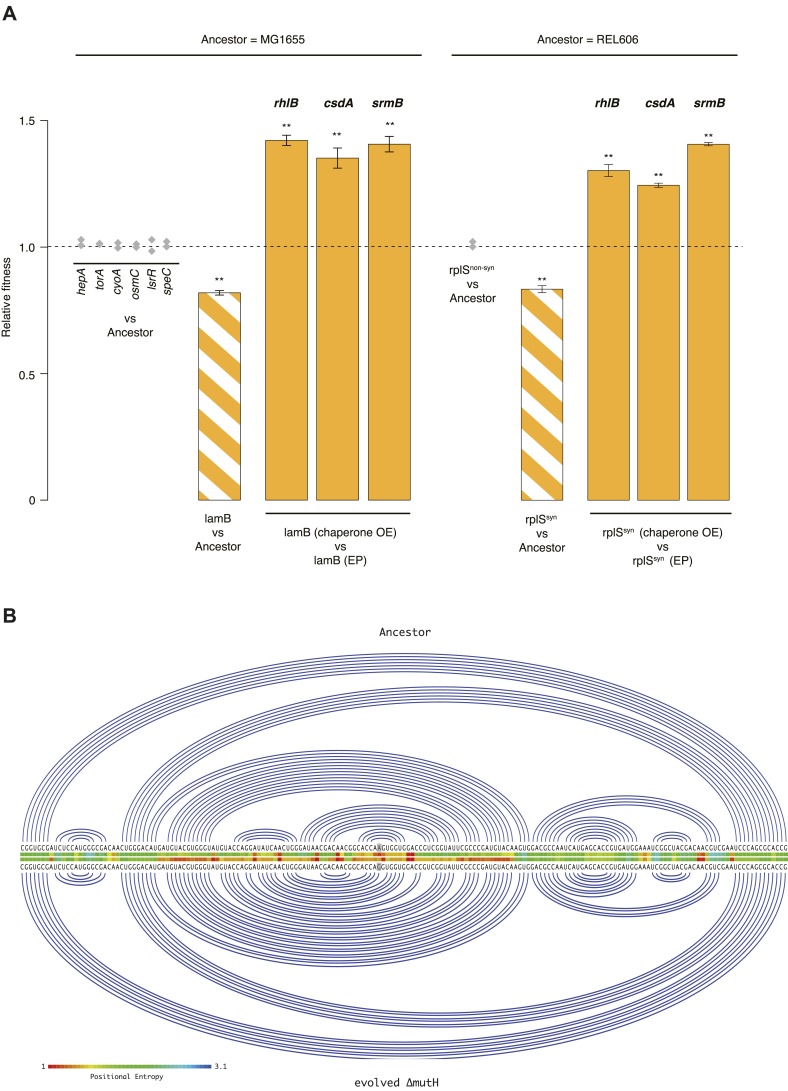
Fitness effects and buffering of individual mutations.(A) Relative fitness of strains carrying single point mutations introduced into the relevant ancestral background competed against the respective ancestor. The mutations correspond to those listed in Supplementary files 2, 3 for the respective genes. Initial screening for fitness defects involved two biological replicates (grey diamonds). For the two mutations where the initial screen suggested a measurable fitness deficit, lamB and rplSsyn, all competitions were carried out in quadruplicate. Bar heights and error bars are as described in Figure 1. **p < 0.01, *p < 0.05 (one-sample t-test). OE: overexpression; EP: empty plasmid. Additional results for competitions terminated in mid-exponential phase (after 2 hr) are shown in Figure 3—figure supplements 1, 2. (B) Linear Feynman graph of the lamB region that harbours the mutation in the evolved ΔmutH strain (highlighted in grey). We predicted RNA secondary structure for the entire malK-lamB-malM transcription unit (RegulonDB identifier: ECK120009315) and its mutated counterpart using RNAfold (Lorenz et al., 2011). The malK-lamB-malM operon contains a repetitive extragenic palindromic (REP) element downstream of lamB, which prevents premature degradation of the lamB cistron following cleavage from malM. Resolution of this REP element as part of regulated degradation was previously shown to require RhlB (Khemici and Carpousis, 2004). However, comparison of predicted minimum free energy structures between wild type and mutant malK-lamB-malM transcripts suggested structural changes that do not interfere with REP element formation but rather lead to decreased positional entropy at the local level, as highlighted here.